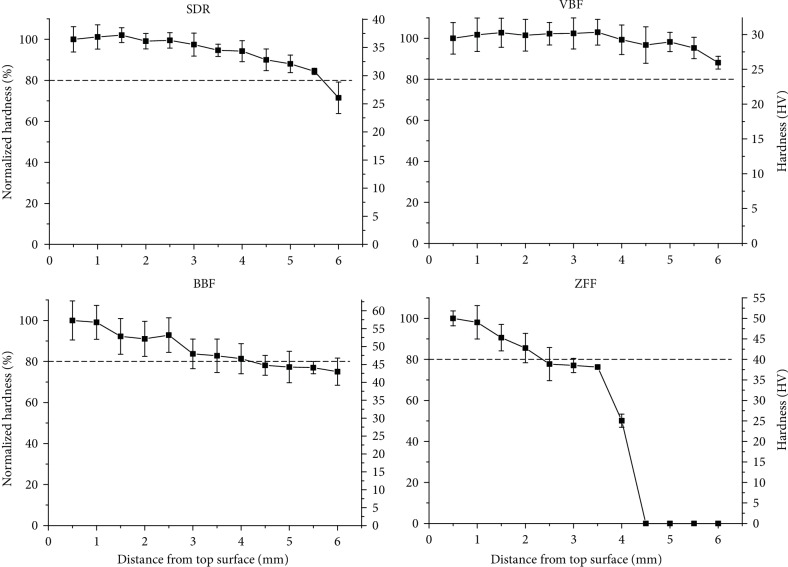
Vickers hardness (n = 9) depending on the distance from the top surface of bulk-fill and conventional flowable resins after a single light-curing session. The dotted line indicates 80% normalized hardness compared with the value at 0.5 mm. The bulk-fill resins (SDR, VBF, and BBF) maintained a normalized hardness of approximately 70-90% even at 6 mm from the top surface, while that of the conventional flowable resin (ZFF) decreased to 0% after 4.5 mm.